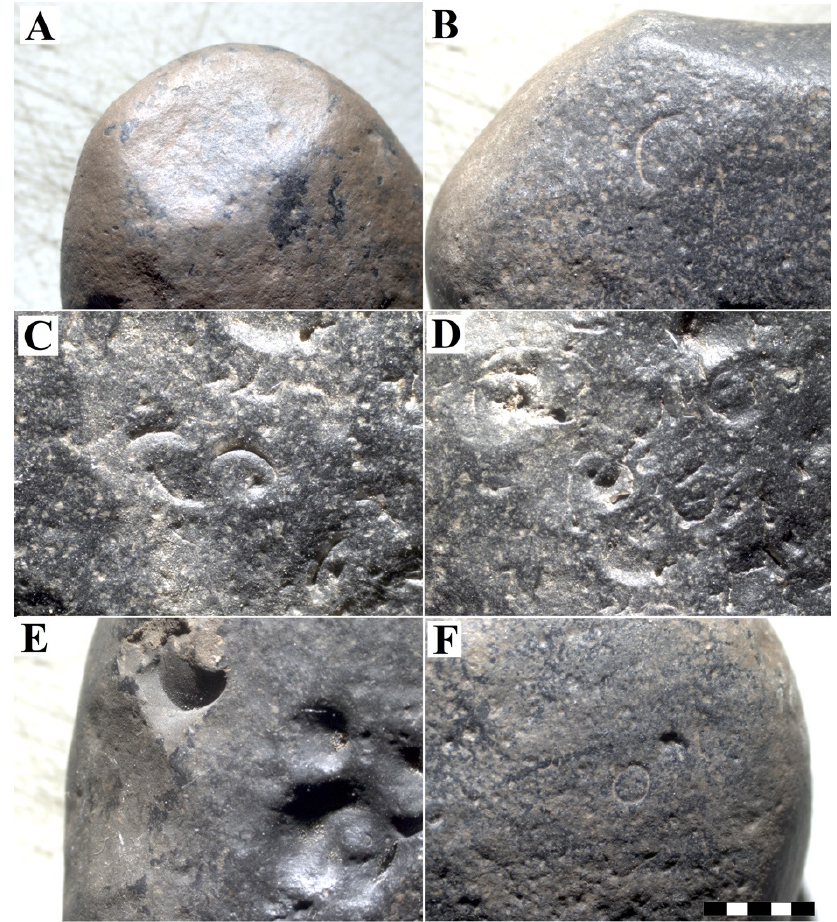
Figure 6. Main characteristics of the non-fractured natural samples prior to experimentation. Rounded, polished edges and a brownish desert patina ( A , B ), a rough surface with clustered cres- centic marks ( C , D ) and rounded, clustered and isolated “crater” shaped notches ( E , F ) are visible. Isolated crescentic marks were also observed ( B , F ). The bottom right bar measures a total of 5 mm, the same from ( A – F ).